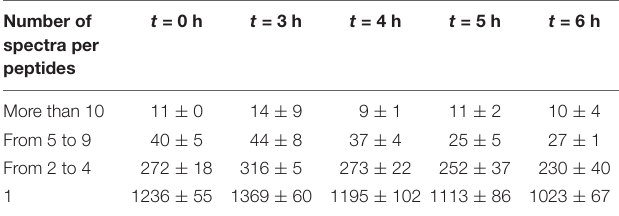
TABLE 3 | Average number of peptides identified as a function of their relative abundance.